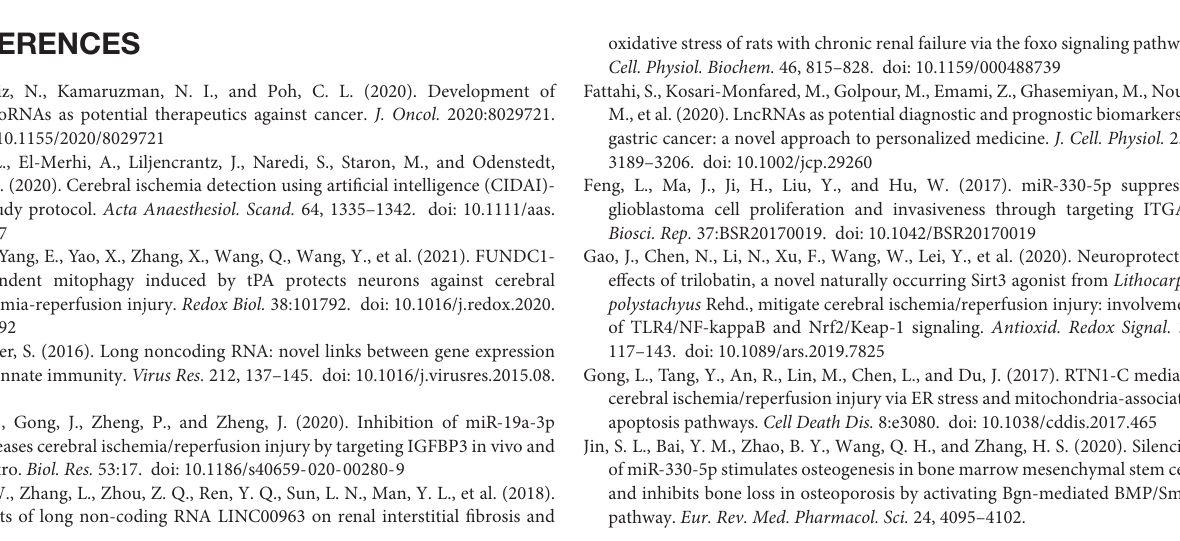
Supplementary Figure 1 | Knockdown of ATP2B1-AS1 decreases the expression of TNF- α , IL-1 β , and IL-6 in OGD/R PC12 cells. The protein levels of TNF- α , IL-1 β , and IL-6 in the OGD/R-induced PC12 cells was determined by Western blot. * P < 0.05, ** P < 0.01, *** P < 0.001. Supplementary Figure 2 | Effect of ATP2B1-AS1 on TLR4 expression. The expression of TLR4 in PC12 transfected with shRNA or ATP2B1-AS1 overexpression plasmid was determined by Western blot. ** P <